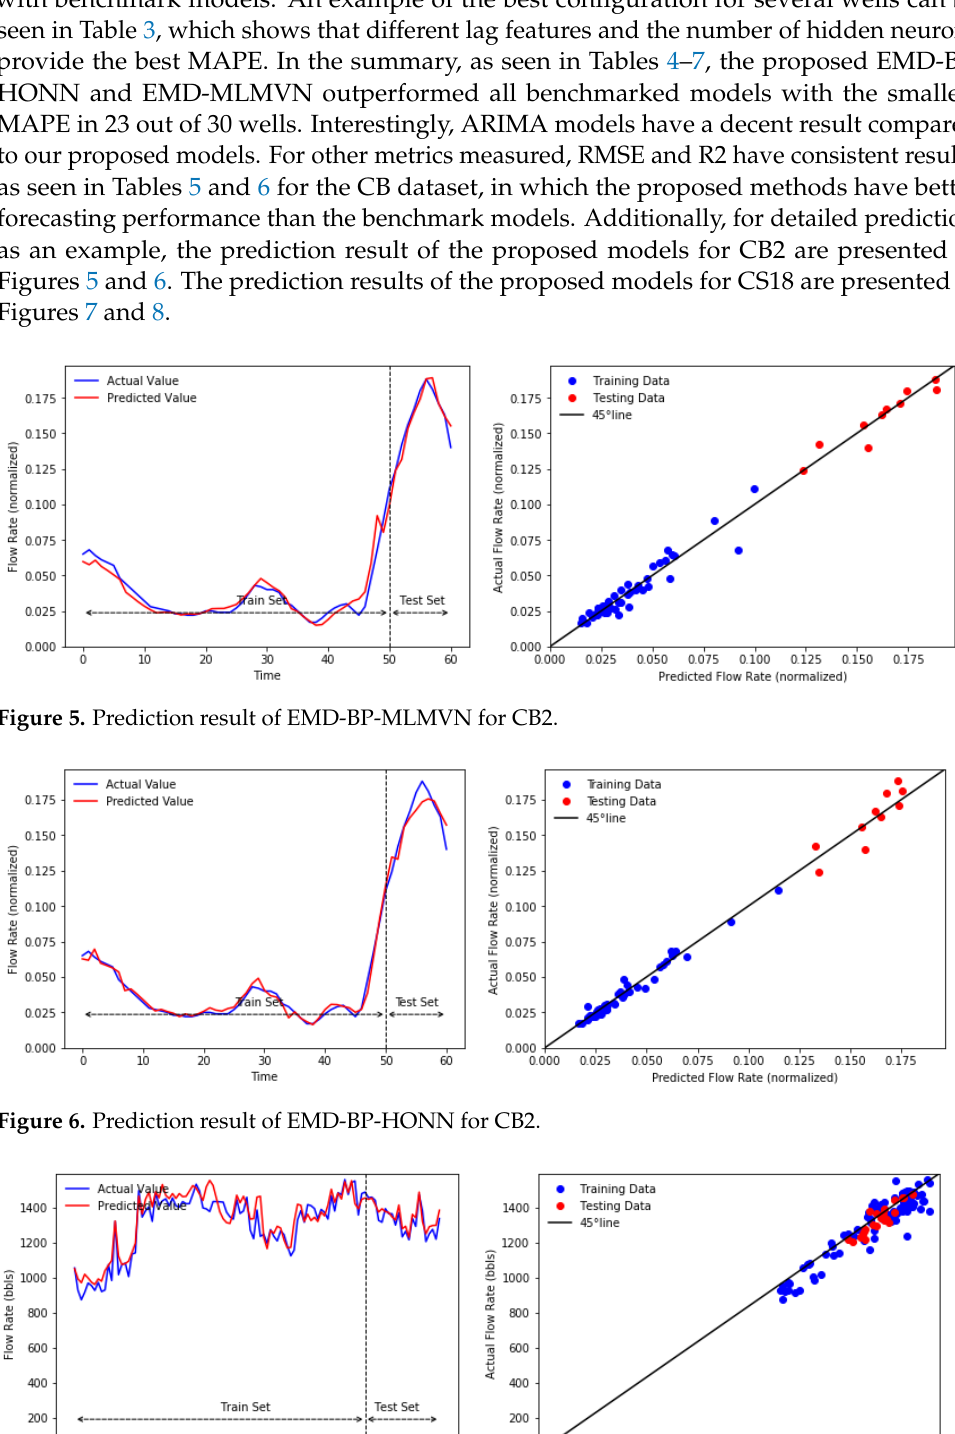
Figure 8. Prediction result of EMD-BP-HONN for CS18. Table 3. Best result of HONN-based methods on several wells. Well